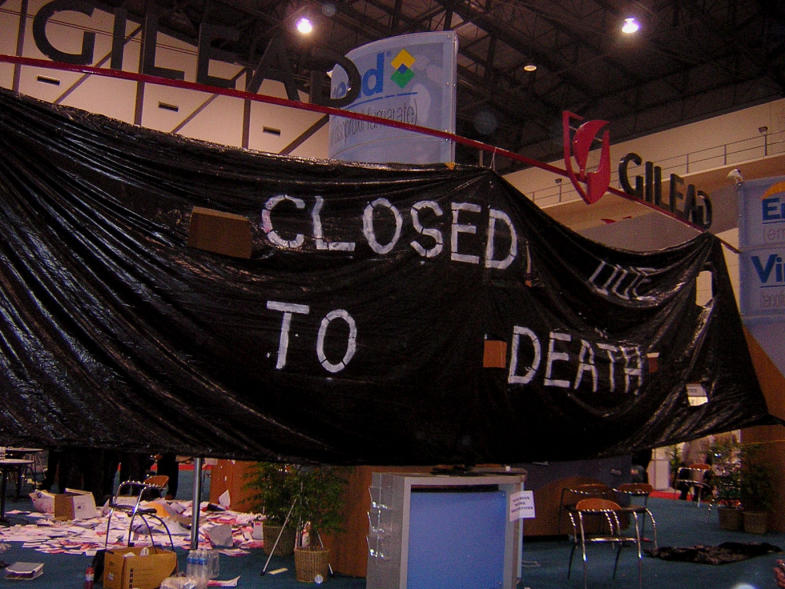
The Protest Closed the Gilead Booth at the International AIDS Conference 2004(Photo: Act Up–Paris)